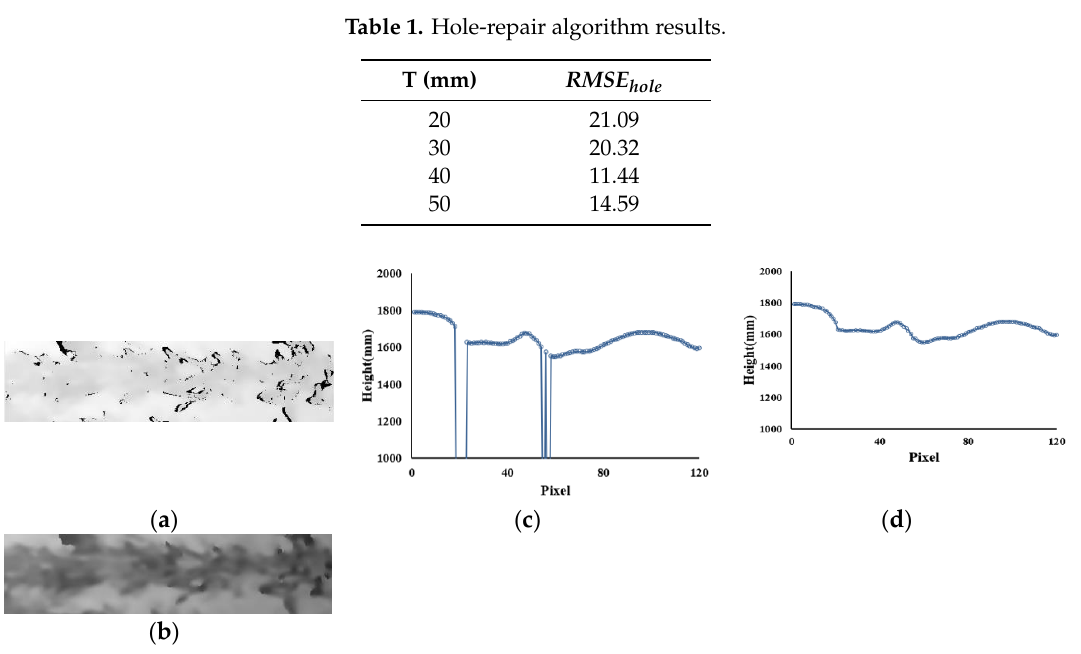
Figure 5. Depth image hole-repair results: ( a ) grayscale depth image; ( b ) repaired depth image; ( c ) and ( d ) original depth information and repair result of the 16th column of the image, respectively. (the grayscale difference between ( a , b ) is due to the fact that the grayscale range is inconsistent when the image is displayed.).